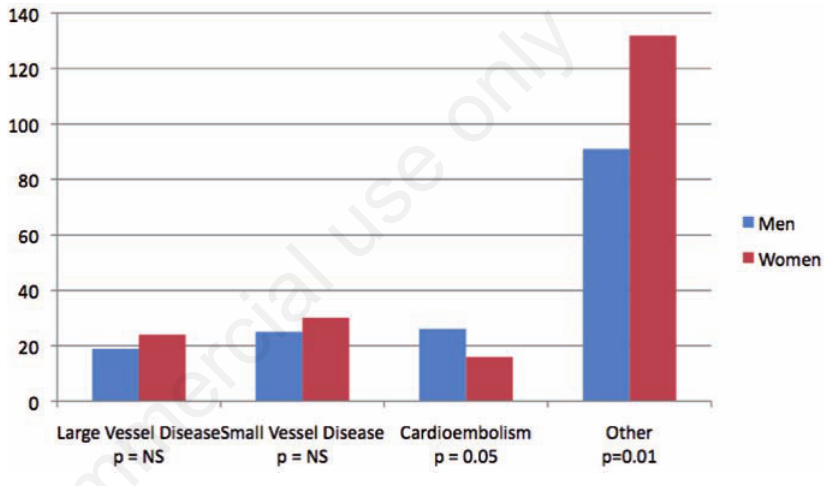
Figure 1. Stroke etiology (TOAST categories) in men and women (X axis: stroke subtype and Y axis: number of strokes).